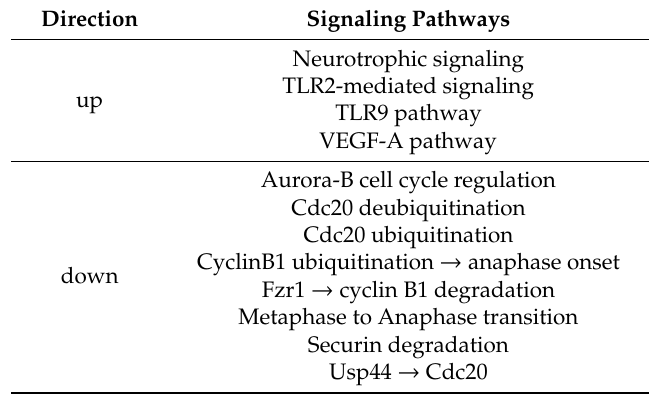
Table 1. Unidirectional signaling pathways associated with modified LDL and latex beads (reported: [54]).